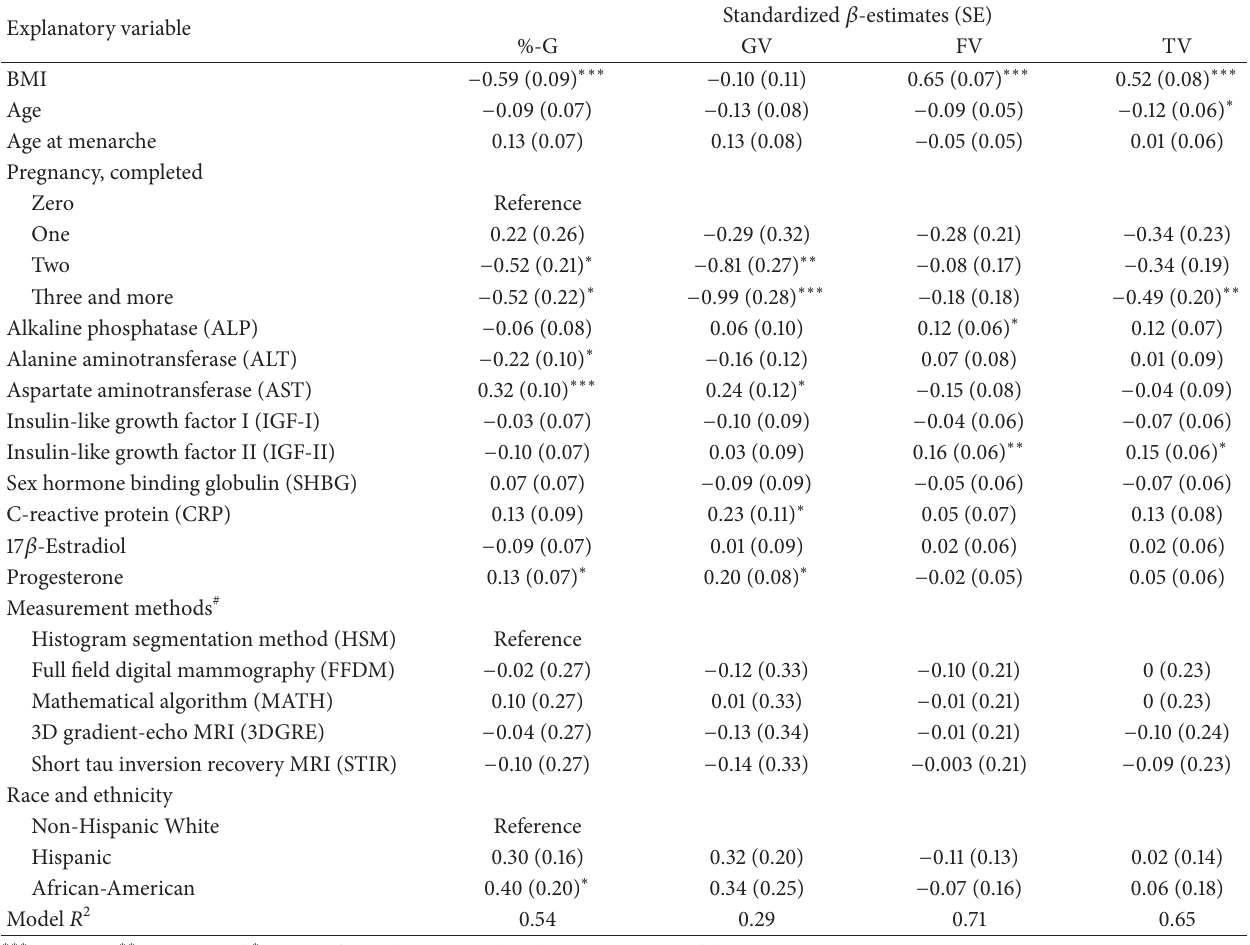
Table 4: Multivariate analysis model estimates for percent breast density (%-G), fibroglandular tissue volume (GV), fat tissue volume (FV), and total breast volume (TV) measured by five different methods ( 𝑛 = 137